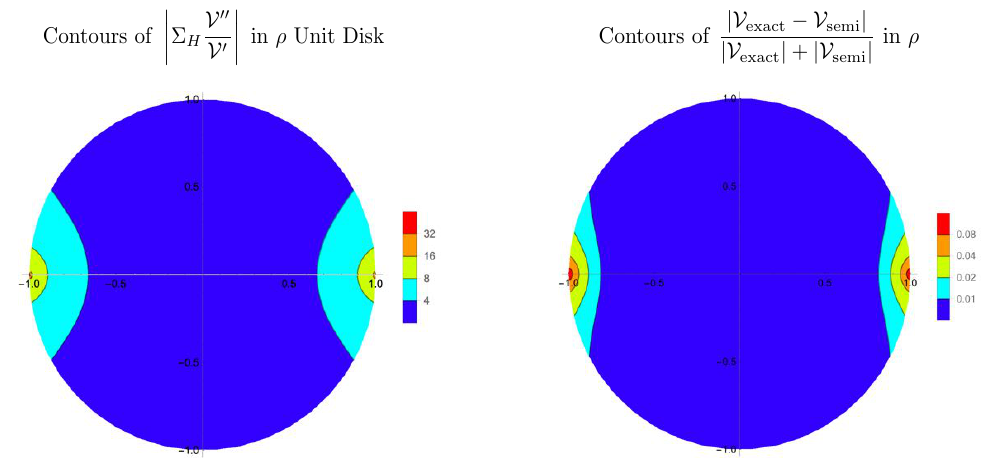
Figure 18 . The (cid:12)gure on the left shows a contour plot of the function in the (cid:26) unit disk with h L = 1 and h H = c not include a black hole | instead it corresponds to a light probe interacting with a de(cid:12)cit angle in AdS 3 . Thus there are no forbidden singularities, and the semiclasssical approximation is reliable in a much larger region as compared to (cid:12)gure 17 (note the di(cid:11)erence in scales). The (cid:12)gure on the right is the deviation of the exact and semiclassical Virasoro vacuum blocks with the same parameters and c = 60. The plot on the left can be viewed as a kind of analytic prediction for the deviation plotted on the